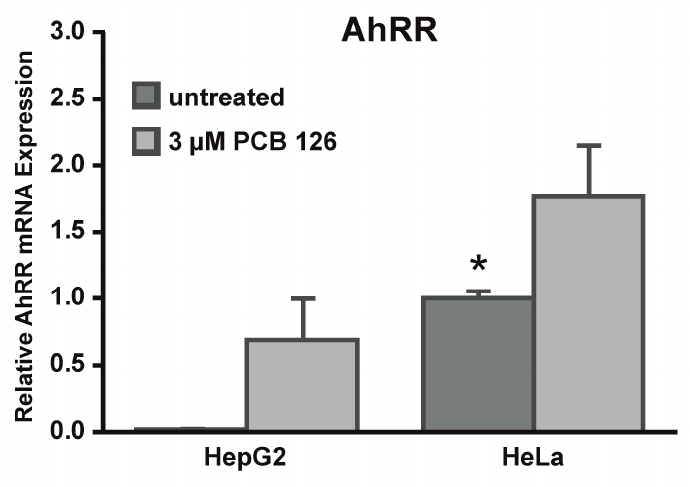
Figure 6. Aryl hydrocarbon receptor repressor (AhRR) mRNA expression in HepG2 and HeLa cells. HepG2 and HeLa cells were treated with 3 µM PCB 126 for 6 h and AhRR mRNA expression levels were determined using qRT-PCR. Analysis was performed with normalization to RPLP0. * p < 0.05 HeLa vs. HepG2; Error bars = SEM; n =